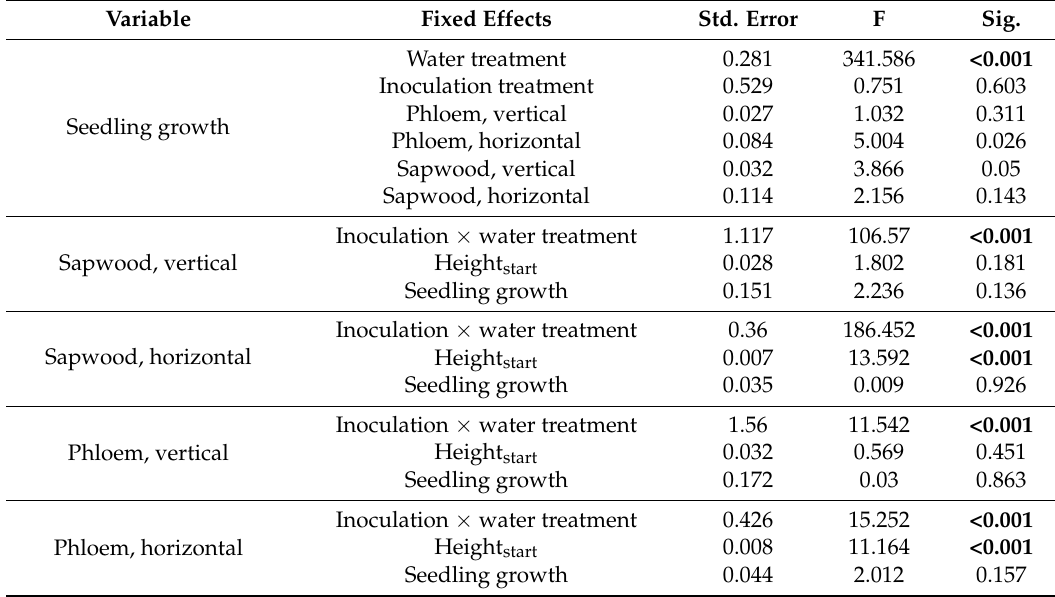
Figure 5. Vertical necrosis (mm) observed in sapwood after inoculation with H. parviporum , H. annosum and mock-inoculated control in high (+group) and low ( − group) water groups as proportions of the sapling growth (mm). The Norway spruce saplings in low water group ( − group) in each treatment grew less during the experiment than in high water group (+group). H. parviporum caused higher necrosis in the low water group ( − group). Table 2. Estimates from the generalized linear models (GML), statistically significant effect ( p < 0.01) are